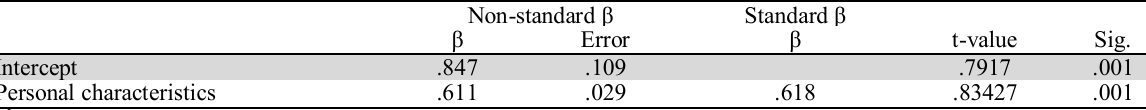
The summary of regression